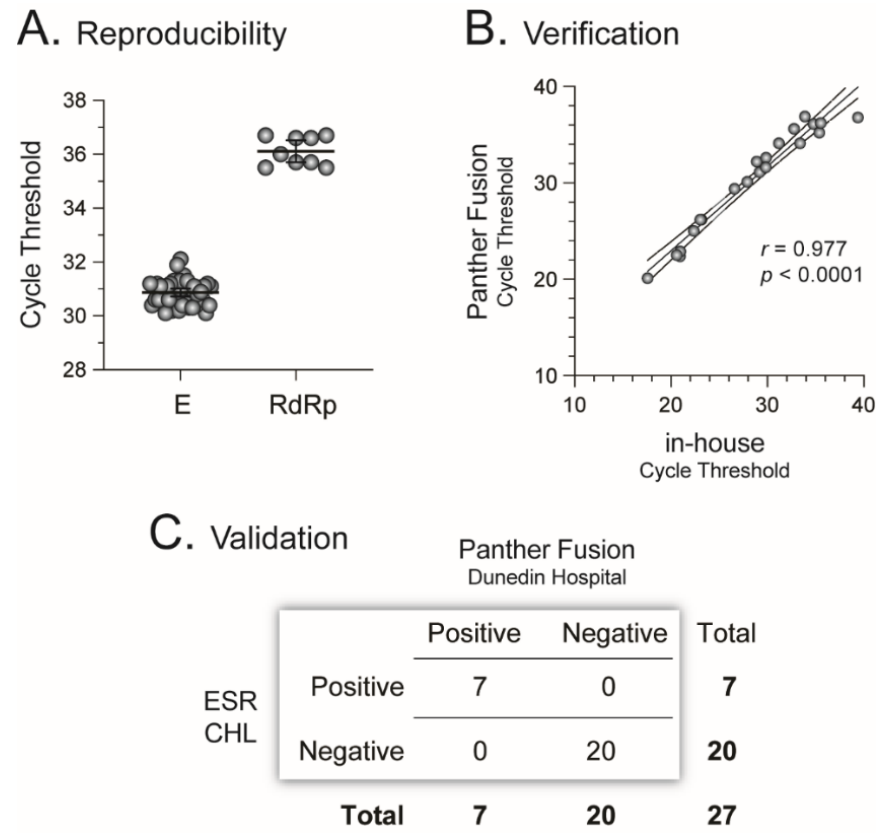
coefficient of variation 1.51%) and 36 (95% CI 35.7–36.5, coefficient of variation 1.47%) for the E and RdRp genes, respectively (Figure 3A).